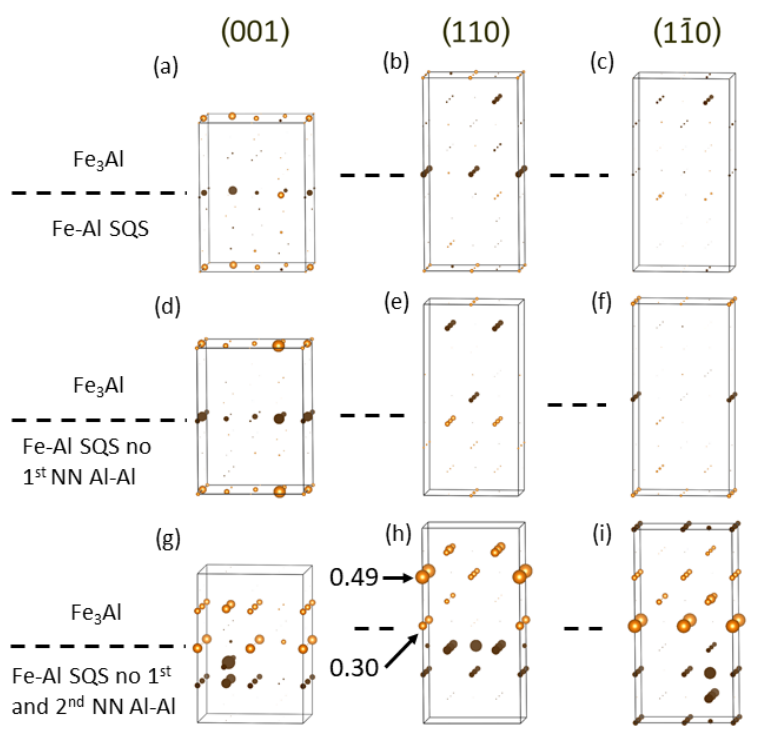
Figure 9. Differences in the magnitude of local magnetic moments of Fe atoms induced by the interfaces within the nanocomposites. They are visualized by the diameter of spheres representing individual Fe atoms (two are listed in subfigure ( h )). Gold (black) color of the spheres indicate positive (negative) changes. The sub-figures ( a , d , g ) correspond to the nanocomposites shown in Figure 7a–c, respectively, the sub-figures ( b , e , h ) to those in Figure 8a–c, respectively, and the sub-figures ( c , f , i ) corresponds to the nanocomposites with the (110) orientation of the interfaces (not shown). Please note that due to the fact that the differences are rather small, the scaling connecting the value of the difference and the diameter of the spheres is three times bigger than the scaling applied in Figure